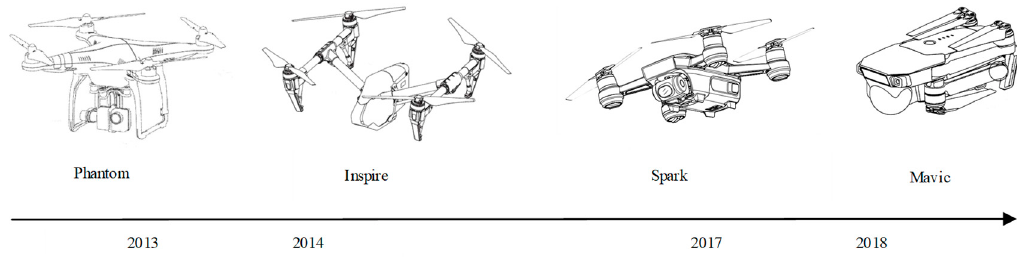
Figure 9. DJI’s unmanned aerial vehicle series products.